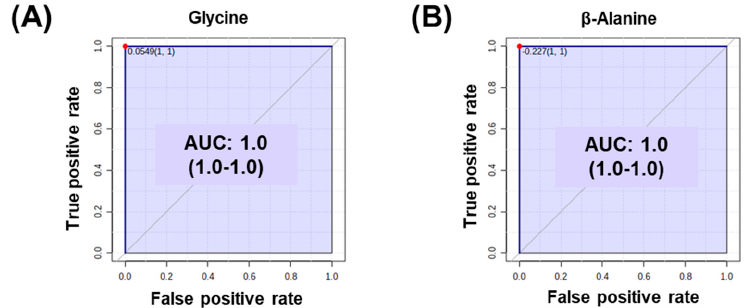
Figure 6. Receiver operating characteristic (ROC) curves of glycine ( A ) and β -alanine ( B ) that differed significantly in the serum of beagle dogs fed a regular diet with medium and high concentrations of black ginseng extract.